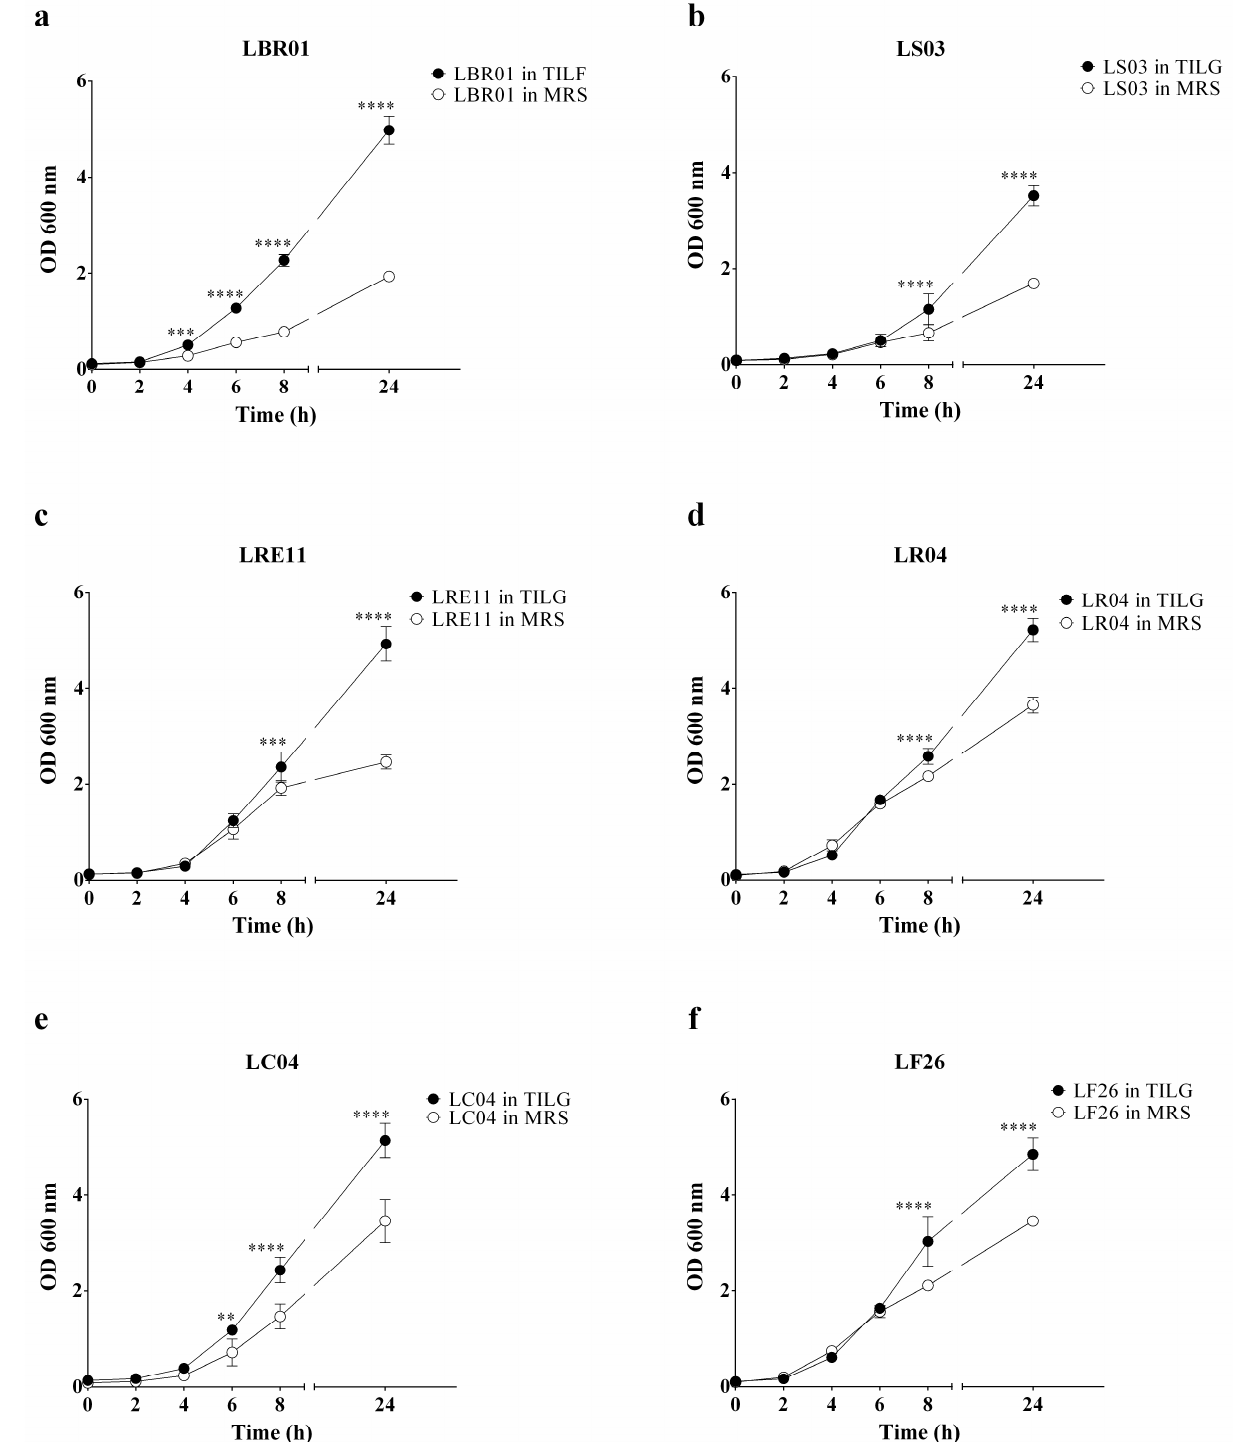
Figure 1. Probiotic growth curves. Probiotic growth curves in MRS and TIL media of ( a ) LBR01, ( b ) LS03, ( c ) LRE11, ( d ) LR04, ( e ) LC04, and ( f ) LF26. Data are expressed as the mean of three independent experiments ± SD. OD 600 nm = optical density at 600 nm. ** p < 0.01; *** p < 0.001; **** p < 0.0001.